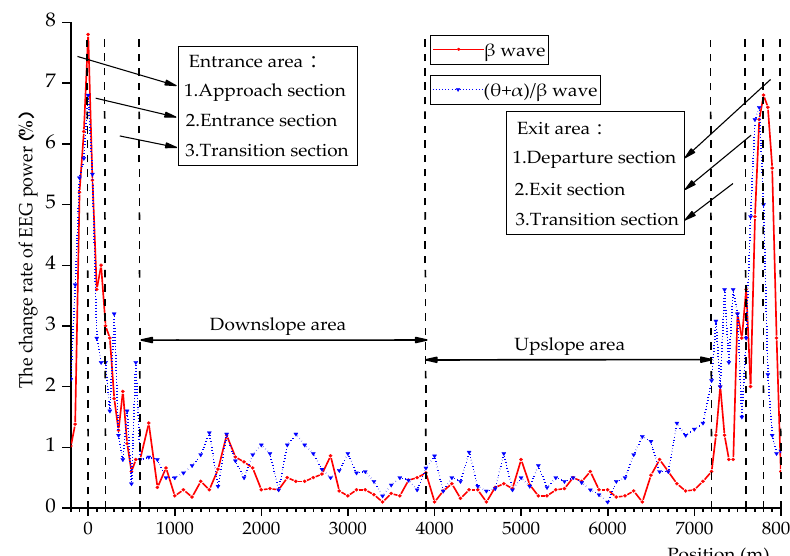
Figure 3. Distribution of the change rate of EEG (electroencephalography) power.